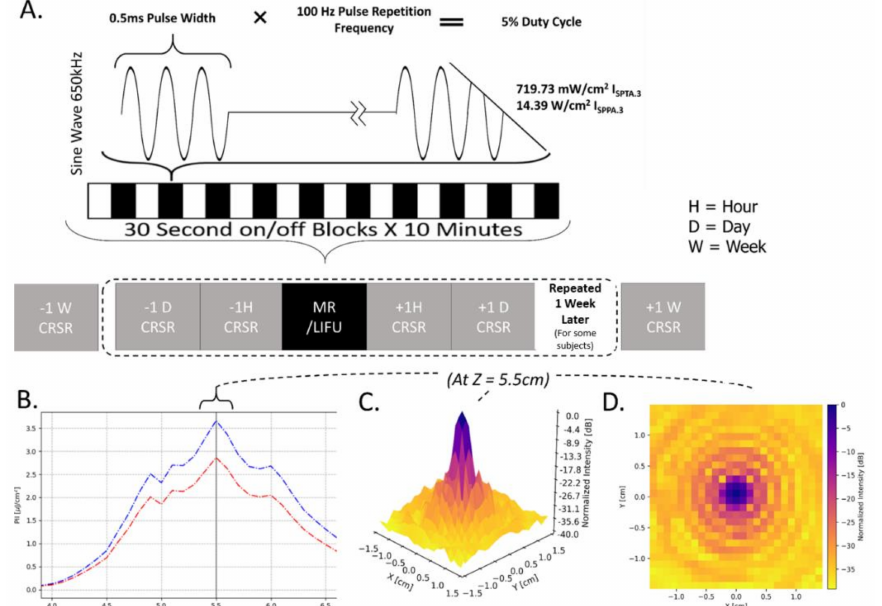
Figure 1. ( A ) Depiction of study protocol involving LIFU parameters and CRS-R (Coma Recovery Scale-Revised) assessments. ISPTA.3 = Spatial Peak Temporal Average Intensity.3. ISPPA.3 = Spatial Peak Pulse Average Intensity.3 (“0.3” denotes deration (attenuation) due to absorption by tissue at 0.3 dB/cm-MHz). ( B ) Intensity in the longitudinal plane (Z plane, extending from transducer) in absolute (pulse intensity integral (PII); “0.3” denoting absorption in human tissue at 0.3 dB/cm-MHz) values of Z correspond to distance from the transducer surface. Note the peak intensity 5.5 cm from the transducer surface and that a 50% ( − 3 dB) reduction in peak intensity is found in an area approximately 1.5 cm in length. ( C , D ) Intensity in the radial plane (X/Y plane, extending from focal point of ultrasound beam 5.5 cm from transducer surface) shown in both 3 ( C ) and 2 ( D ) dimensions. A 50% ( − 3 dB) reduction in peak intensity occurs in an area approximately 0.5 cm in width. Note that the decibel scale is nonlinear and − 3 dB approximately corresponds to a 50% reduction in intensity; this scale is normalized to maximal intensity, where peak intensity equals 0